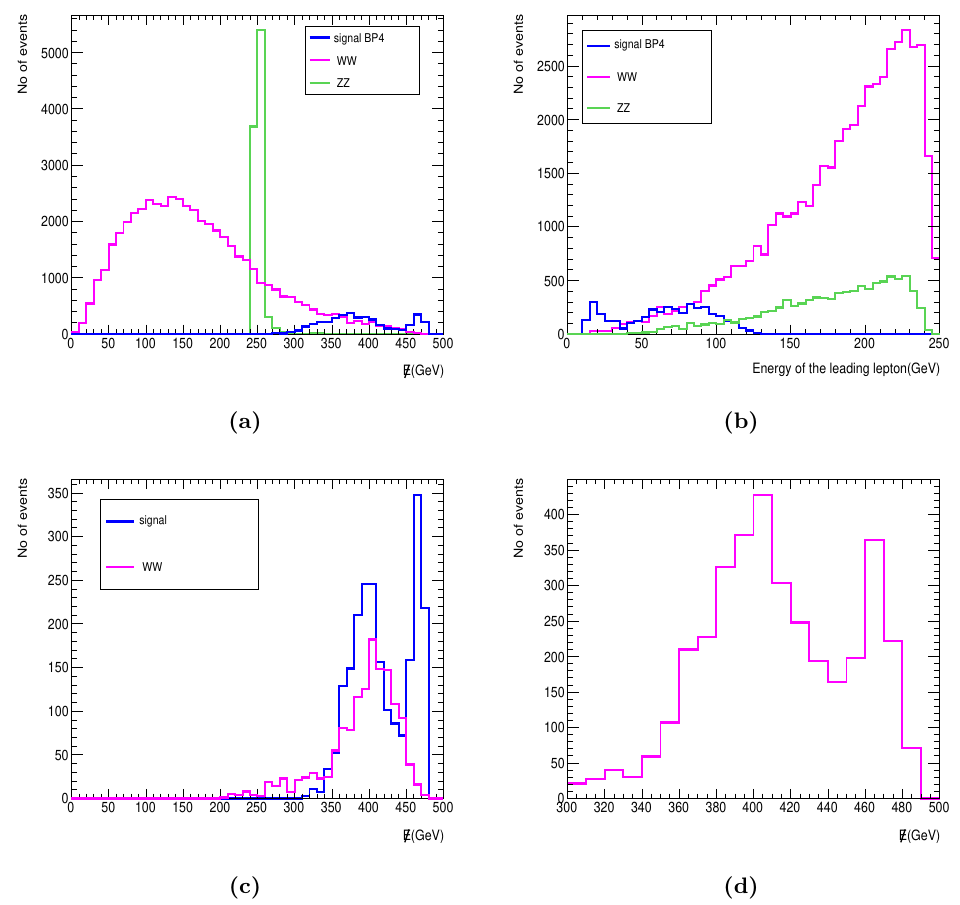
√ s = 500 GeV with E ‘